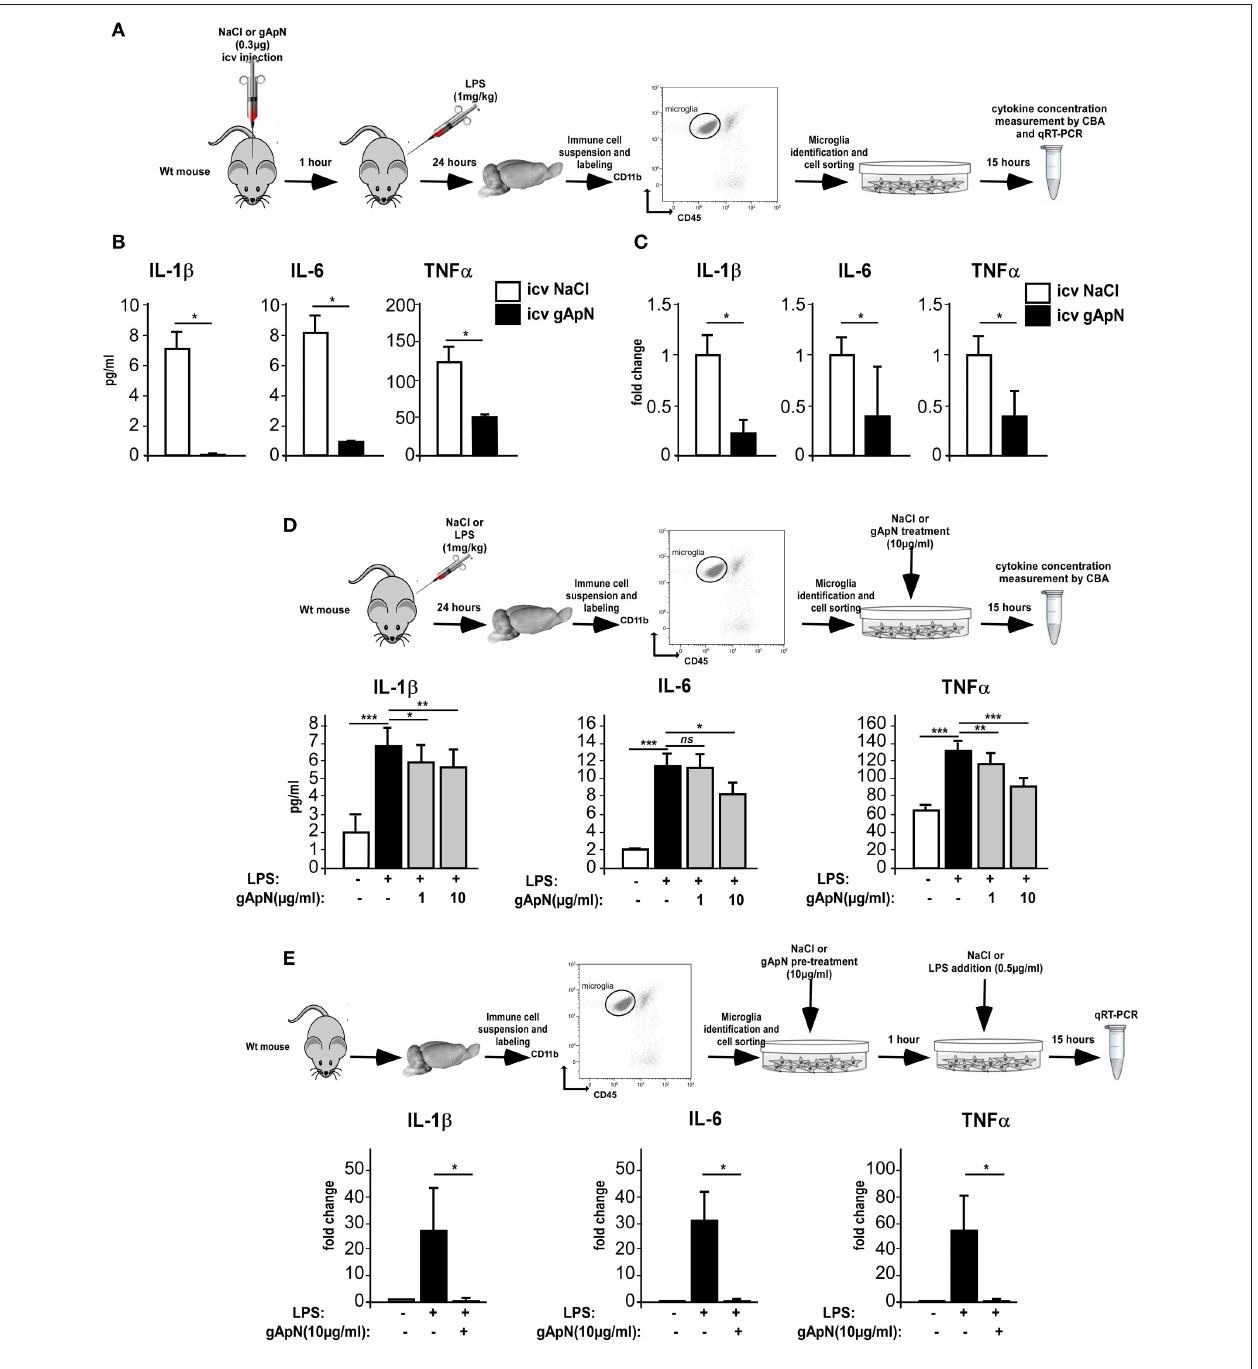
FIGURE 3 | Globular adiponectin limits LPS-induced pro-inflammatory activation of microglia. (A) Schematic representation of the protocol. Wt mice first received i.c.v injection of saline or gApN then LPS ip administration. Levels of IL-1 β , IL-6, and TNF α proteins (B) or mRNAs (C) were quantified by CBA or qRT-PCR, respectively, from microglia sorted out from brains of saline (white bars) or gApN (black bars) i.c.v injected mice. N 3 per group; Mann & Whitney for comparison between = groups, * p < 0.05. (D) Twenty-four hours after saline or LPS ip administration, microglia was sorted out from Wt mouse brains and cultured for additional 15h in the presence of vehicle or gApN in their culture medium. Levels of IL-1 β , IL-6, and TNF α proteins were quantified by CBA from microglia sorted out from brains of saline (white bars) or LPS (black bars) treated Wt mice cultured in absence (white and black bars) or presence of 1 or 10 µ g/ml gApN (gray bars). N 3 per group; = Kruskal–Wallis test followed by the Iman-Conover method for multiple comparison between groups was performed, * p < 0.05, ** p < 0.01, *** p < 0.005; ns, non-significant. (E) Microglia was sorted out from Wt mouse brains and cultured for 1h with saline or gApN as a pre-treatment before addition of LPS. Levels of IL-1 β , IL-6, and TNF α mRNAs were quantified by qRT-PCR, from microglia sorted out from brains of saline (white bars) or LPS (black bars) treated microglia cultured in absence (white and black bars) or presence of 10 µ g/ml gApN (gray bars). N 3 per group; Mann & Whitney for comparison between groups, * p < 0.05. =